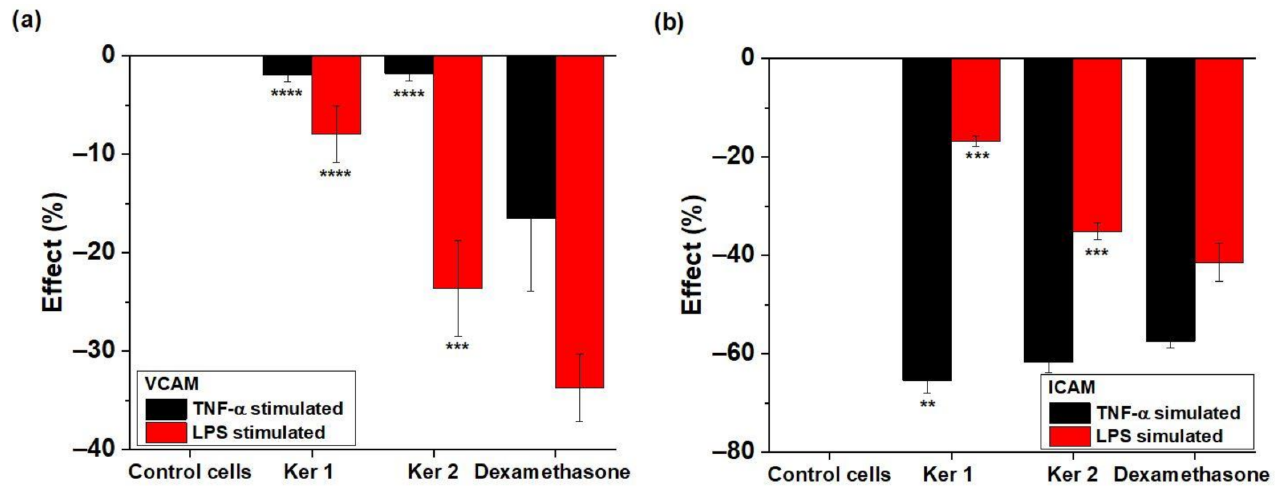
Figure 8. Percentage variation of ( a ) VCAM and ( b ) ICAM expression modulated by Ker1 and Ker2 compared to the cell control. ** p < 0.01, *** p < 0.001, **** p <